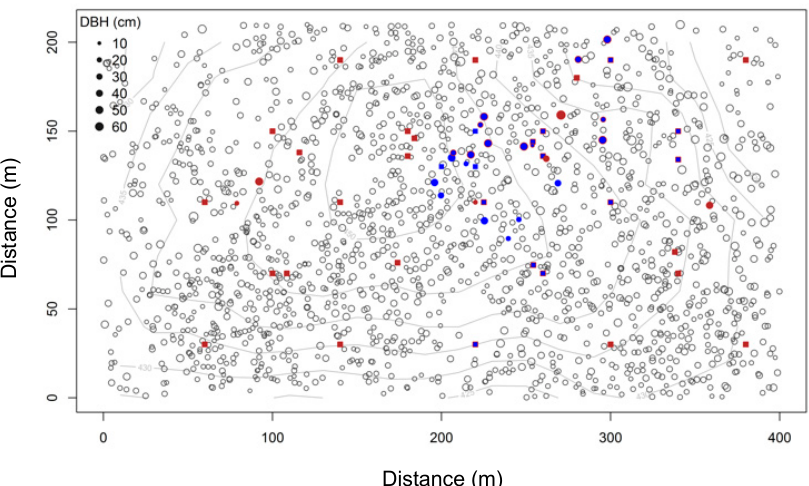
Figure 1. Map of adult sugar maple trees and soil efflux observations: all sugar maple stems with a diameter larger than 15 cm are indicated by empty circles. Bolded points indicate locations of soil efflux measurements. Squares are background fluxes; circles are tree-associated fluxes. Red symbols indicate pre-rain and blue symbols post-rain observations; blue symbols with a red outline indicate the locations with both pre- and post-rain observations. Topographic contours indicate 5-m elevation increments, ranging from 425 to 450 m.